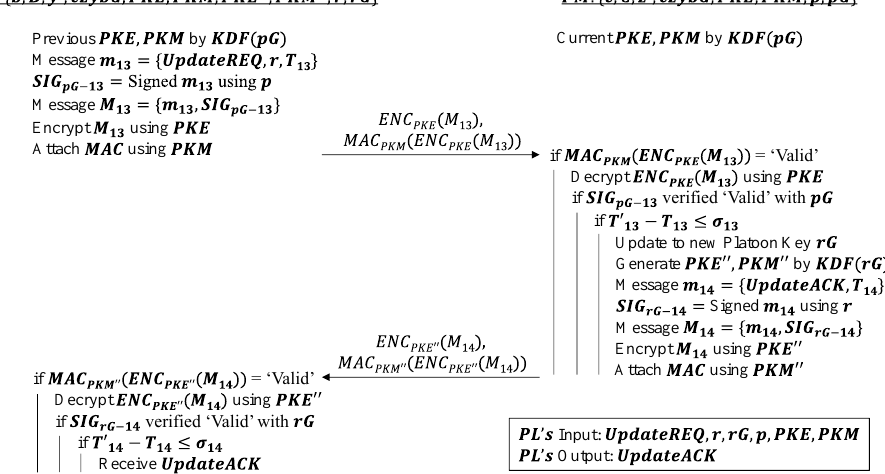
Figure 7. Platoon Key Update Phase of the SPMSA Scheme when a Vehicle Leaves the Platoon.